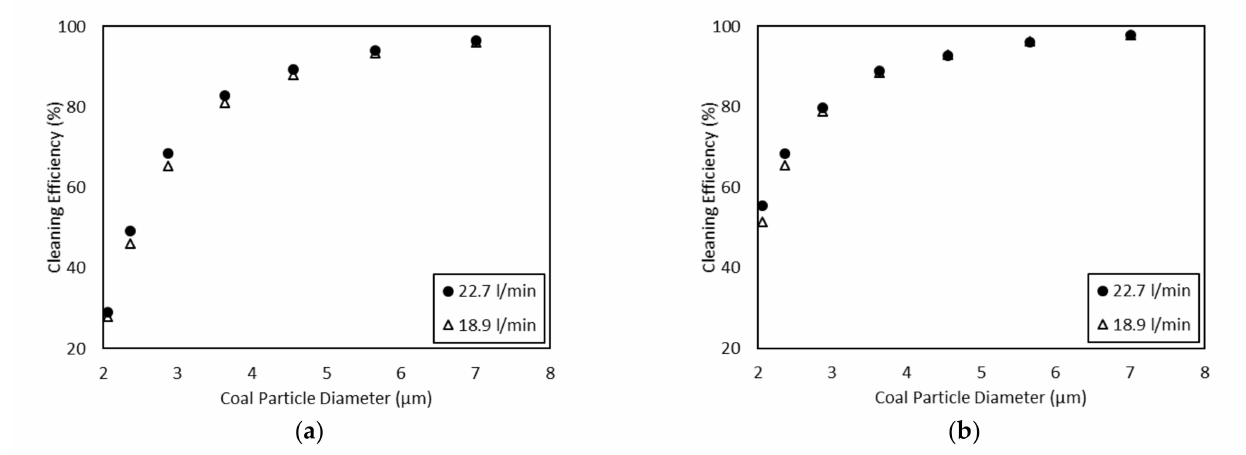
Figure 6. ( a ) Cleaning efficiency comparison of the filter at 1.42 m 3 /s; ( b ) cleaning efficiency comparison of the filter at 2.83 m 3 /s.